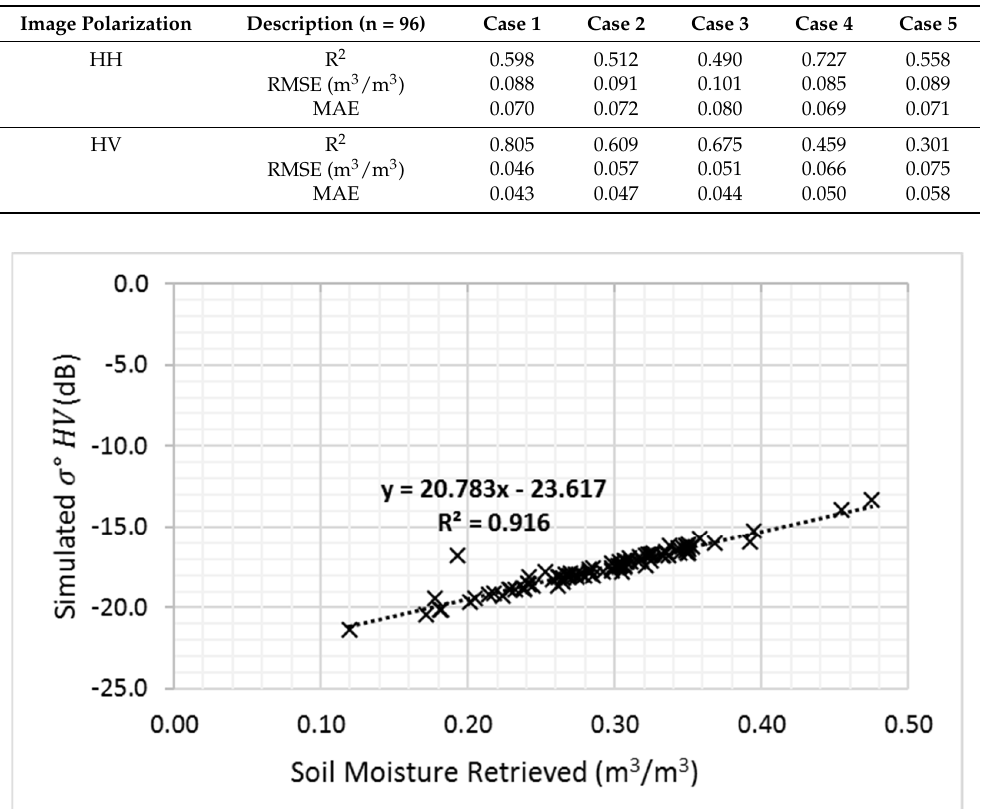
Figure 2. Soil moisture retrieved using vegetation descriptors of V 1 = 1 and V 2 = LAI, and simulated backscatter coefficient of HV polarization.